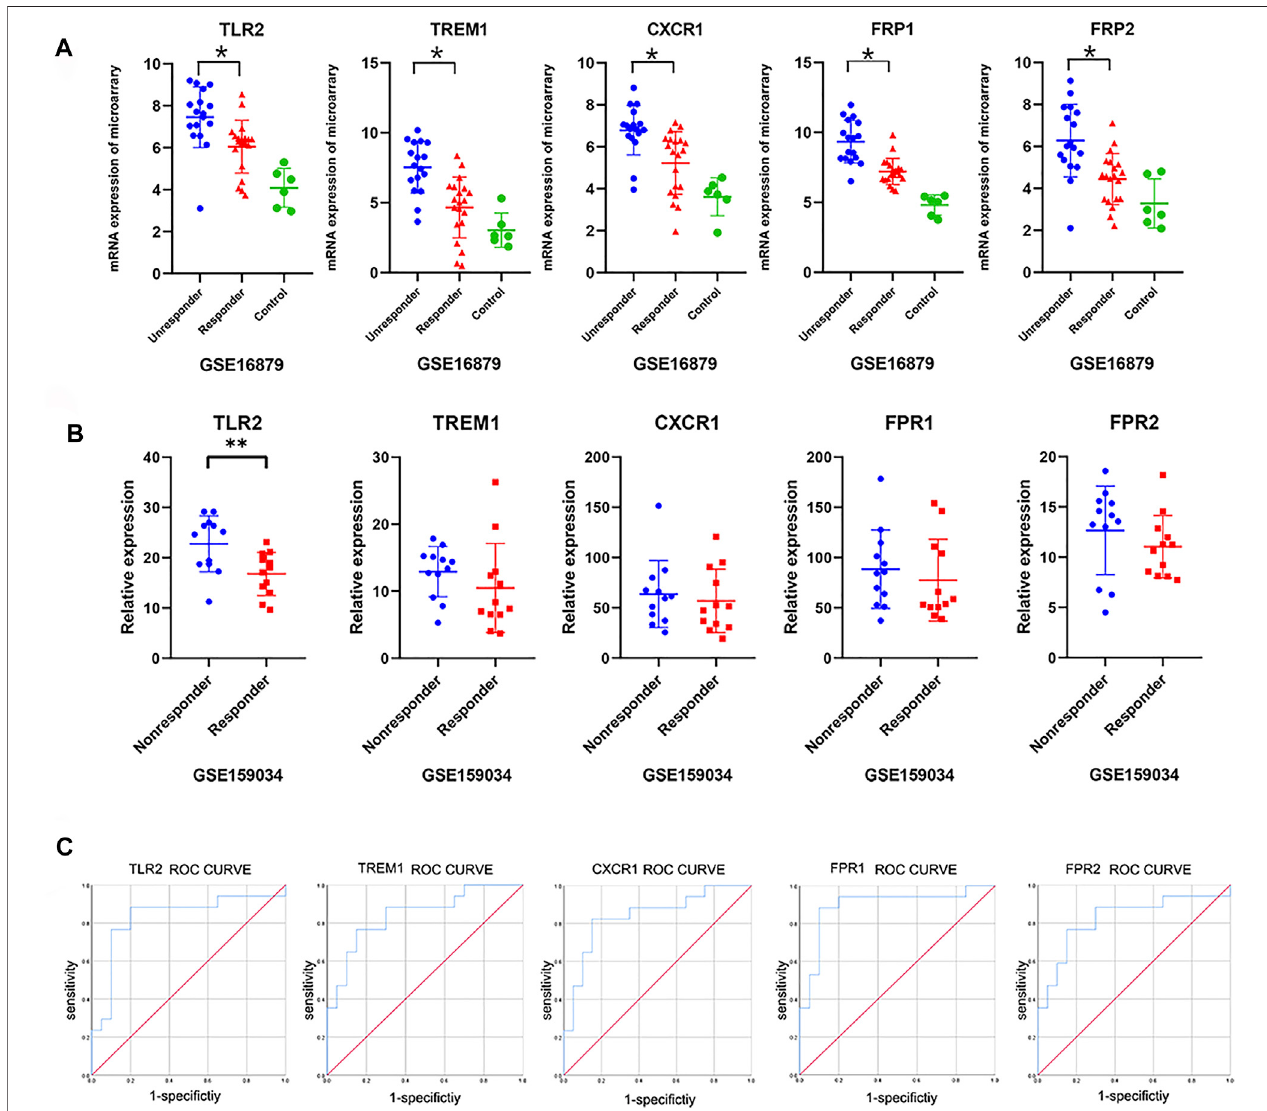
FIGURE 5 | Validation of hub genes and ROC curves. (A) Expression pro fi les of the top fi ve core genes obtained from the above network in the discovery cohort (GSE16879; one-way ANOVA, p < 0.05). (B) Validated expression pro fi les of the top fi ve core genes between responders and nonresponders from an additional independent IBD cohort (GSE159034; one-way ANOVA or unpaired t-tests, * p < 0.05). (C) ROC curves for the top fi ve core genes in GSE16879.